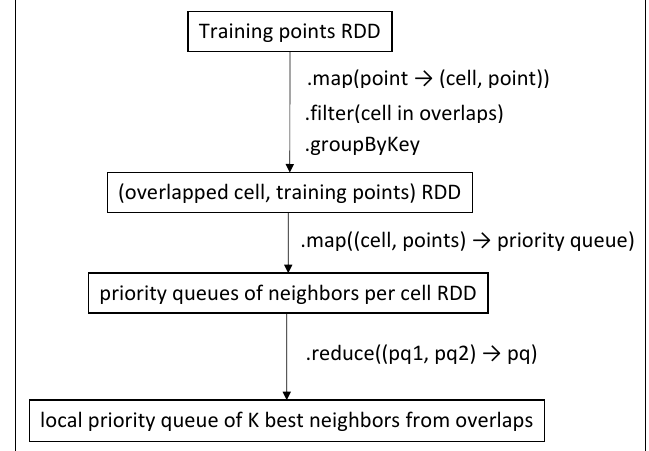
Figure 9. Discover neighbors in overlapped cells (Phases 2 and